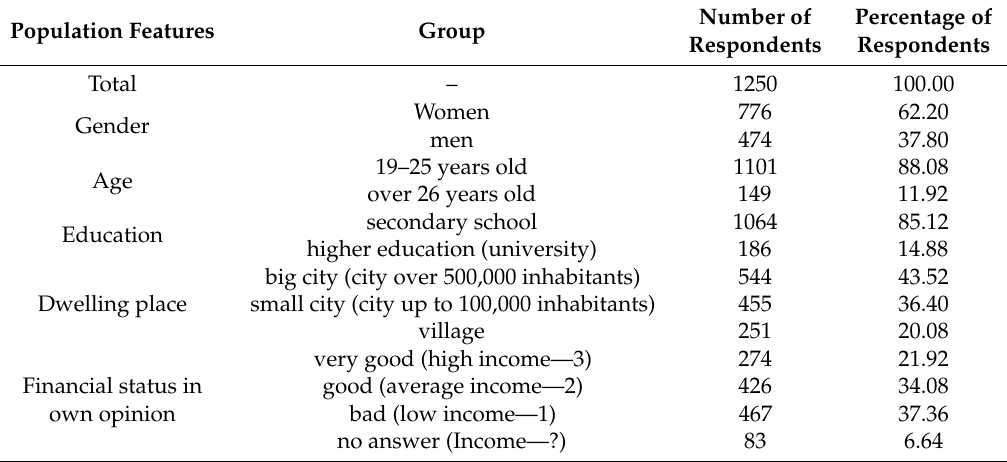
Table 2. Characteristics of the surveyed sample of